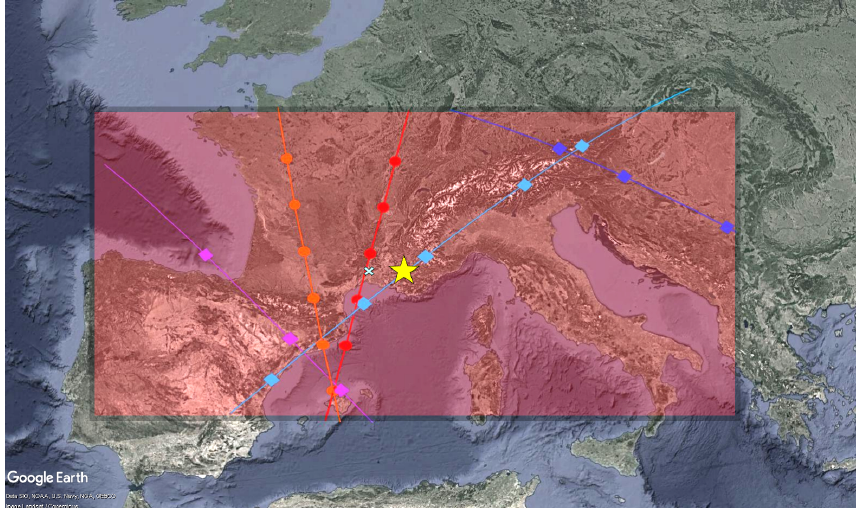
Figure 1. The area defined for coincident measurements during the LAVANDE campaign (39, − 9) to (49,21). Observatoire de Haute-Provence is represented by the yellow star at (43.93,5.71) and Nîmes radiosonde launches by a cyan X at (43.86,4.41). Ascending (red) and descending (orange) orbits for MLS with tangent point locations of profiles for 17 July 2018. Ascending (light blue) and descending (purple and dark blue) orbits for SABER with tangent point locations of profiles for 17 July 2018 (data: © Google Earth Pro,